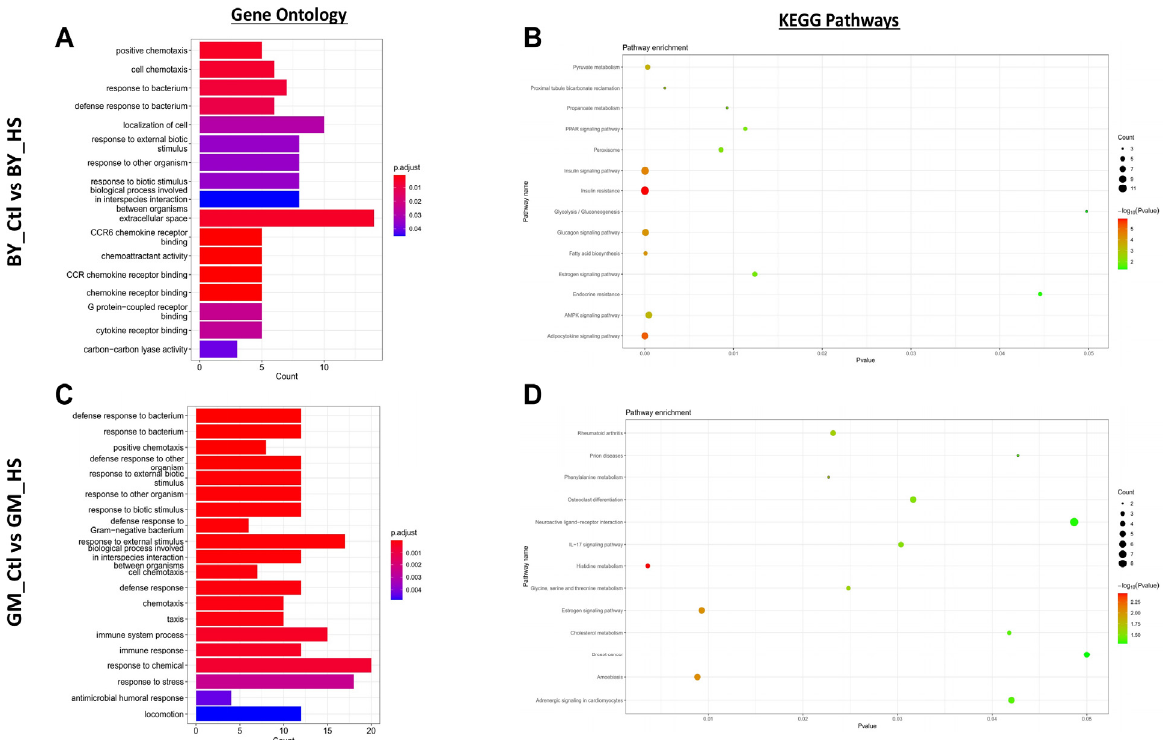
Figure 3. Identification of Gene Ontology (GO) terms and Kyoto Encyclopedia of Genes and Genomes (KEGG) pathways enrichment of Beijing You and Guang Ming chickens in response to heat stress. ( A ) The enriched GO terms are based on the DEGs identified in BY_Ctl vs. BY_HS. ( B ) KEGG pathways enriched based on the DEGs identified in BY_Ctl vs. BY_HS. ( C ) The enriched GO terms are based on the DEGs identified in GM_Ctl vs. GM_HS. ( D ) KEGG pathways enriched based on the DEGs identified in GM_Ctl vs. GM_HS.